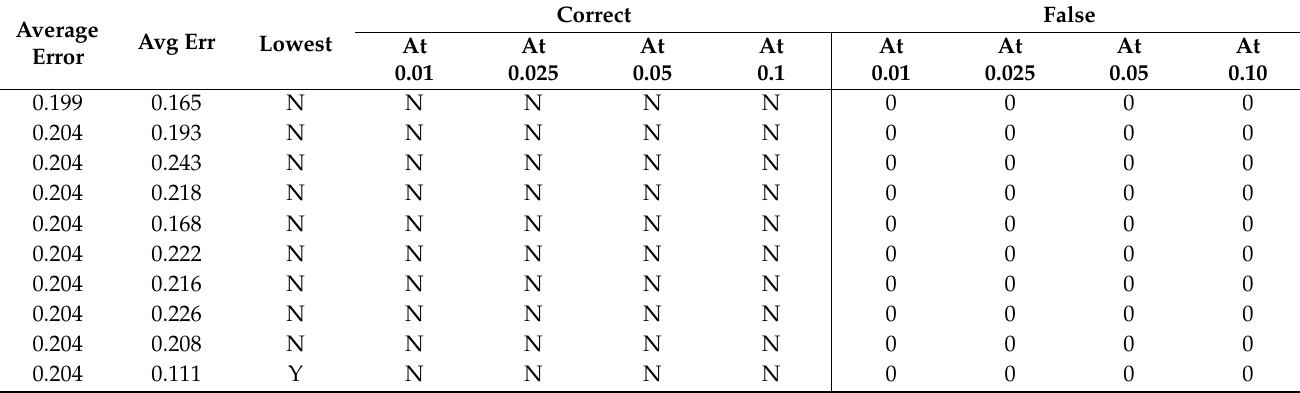
Table 2. Set 1, trials 11–20 summary data (all 0.5 PR